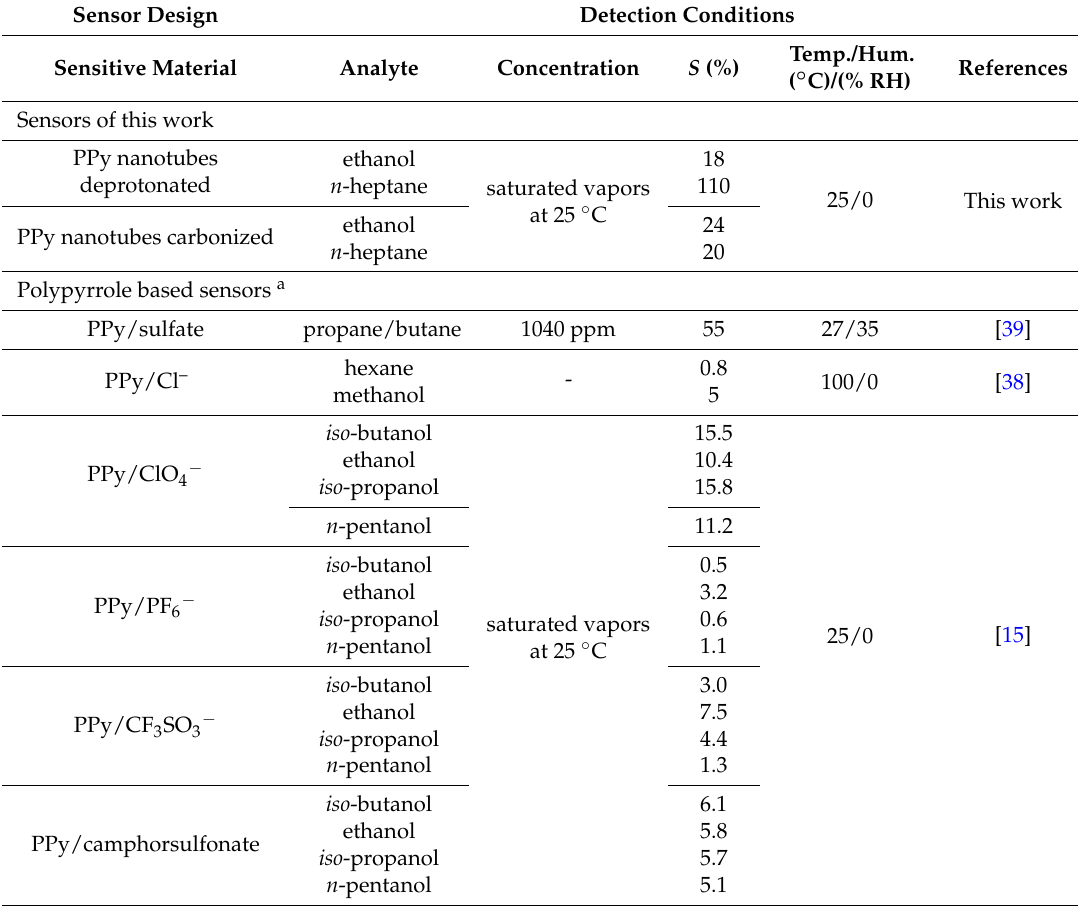
Table 2. Overview of sensitivity of sensors based on PPy nanotubes, nitrogen-containing carbons, and MWCNT. The detected analytes are alkanes and alcohol